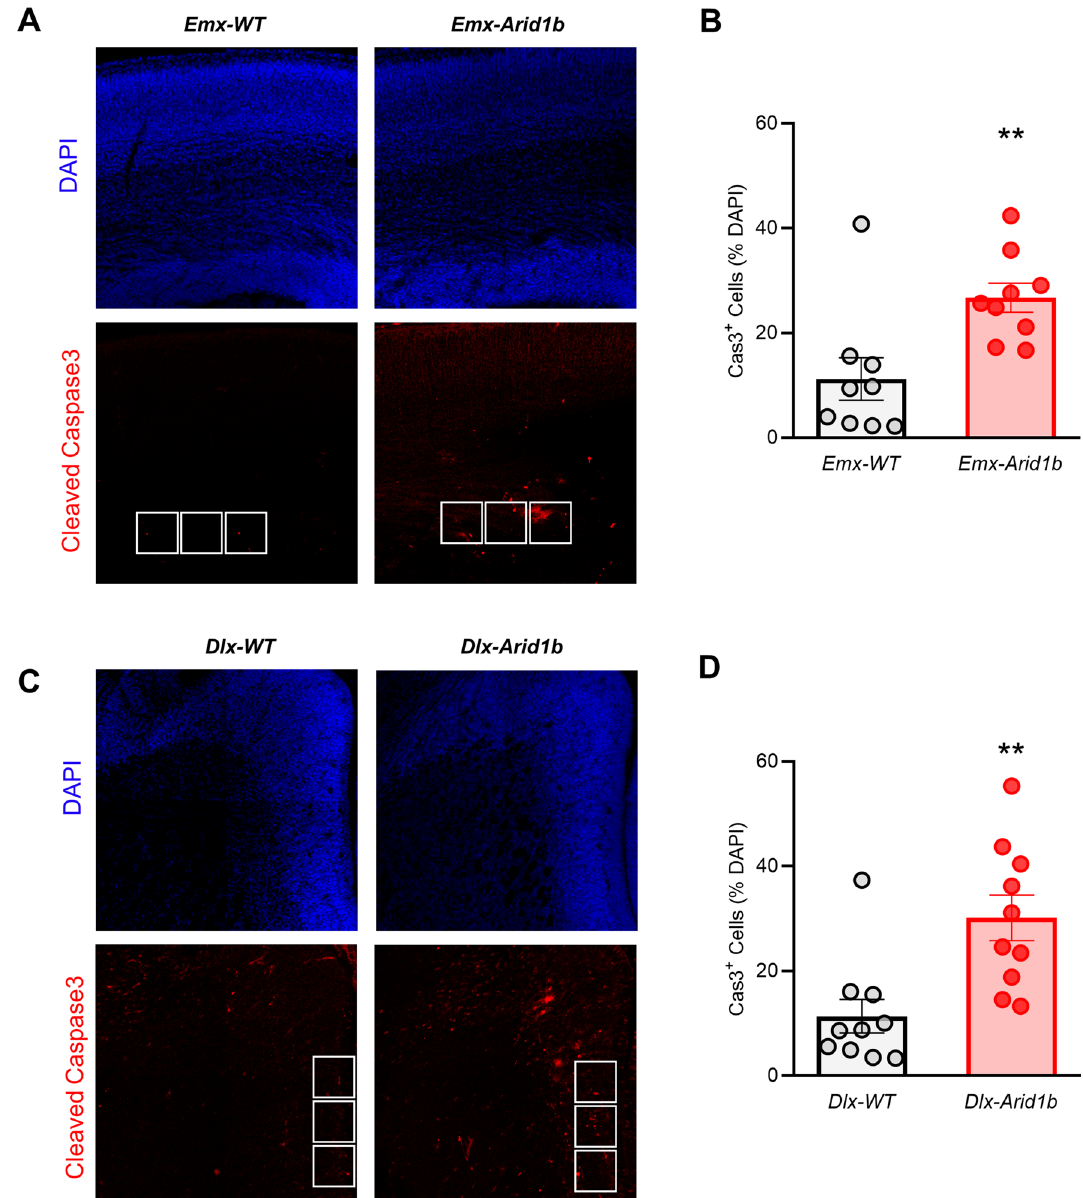
Figure 5. Arid1b deletion increases apoptosis in cortical and ventral neural progenitor pools. ( A ) and ( C ) Cell death was assessed in E14-16 control and Emx-Arid1b or Dlx-Arid1b mutant neural progenitors by immunostaining with a cleaved caspase-3 (cl.-Cas 3) antibody. Representative images from both nine control and Emx-Arid1b brains for ( A ) and ten from each genotype for ( C ). White boxes (2.5 mm 2 ) indicate regions of interest in the VZ of the developing cerebral cortex (for Emx-Arid1b mice) or MGE (for Dlx-Arid1b mice) that were quantified and averaged for each animal. ( B ) and ( D ) Quantification of apoptotic cells (the percentage of DAPI cells positive for cl.-Cas 3) from ( A ) and ( C ), respectively. N = 9 mice for each genotype for ( A ) and N = 10 mice for each genotype for ( C ). Statistical significance was determined by two-tailed Student’s t test. Error bars show SEM. ** p <